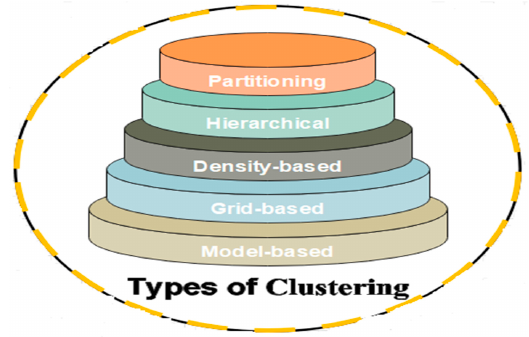
Figure 1. Types of clustering methods [29].